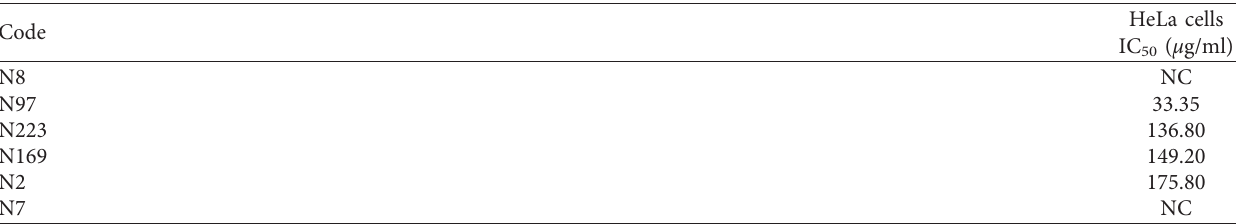
Table 2: Anticancer screening of endophytic fungi extracts on uterine cervical cancer cells (HeLa). The anticancer activity was determined via MTT assay after exposure to metabolite extracts for 48 h.